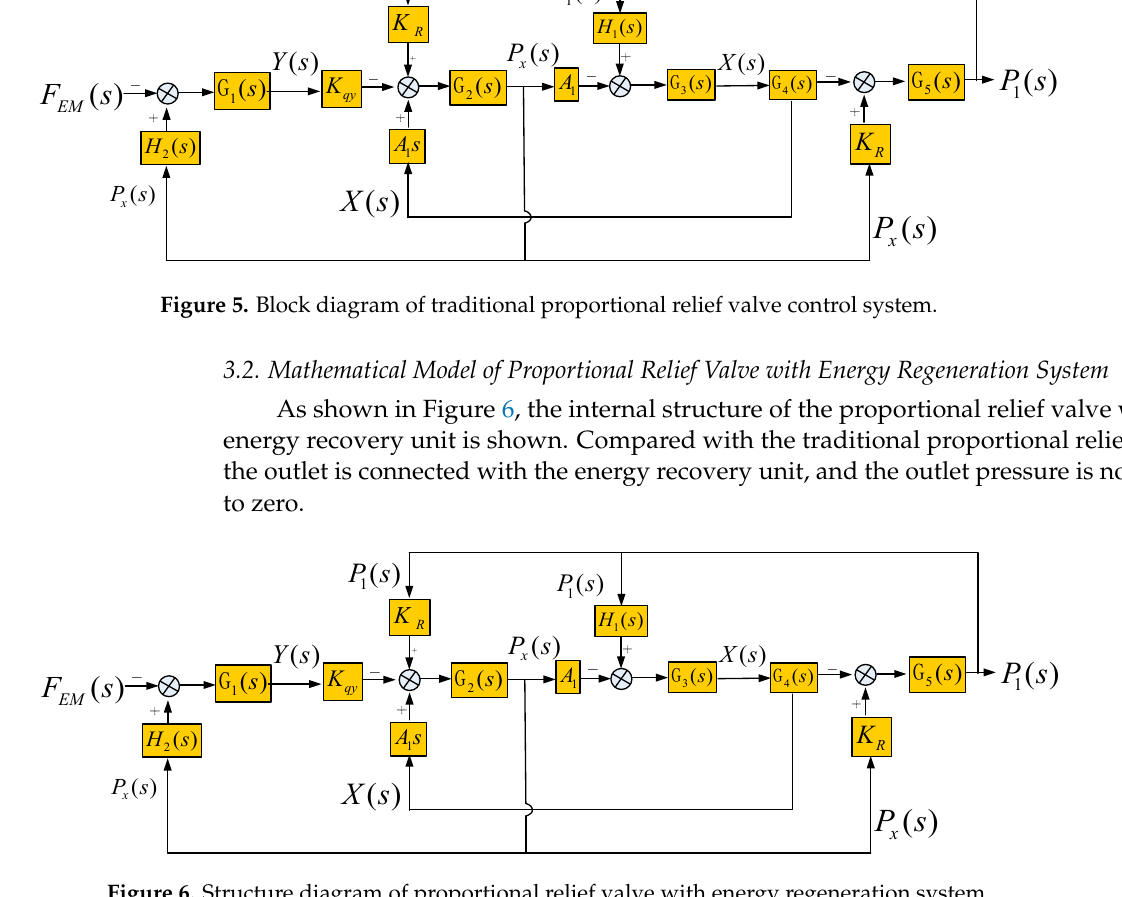
Figure 6. Structure diagram of proportional relief valve with energy regeneration system.